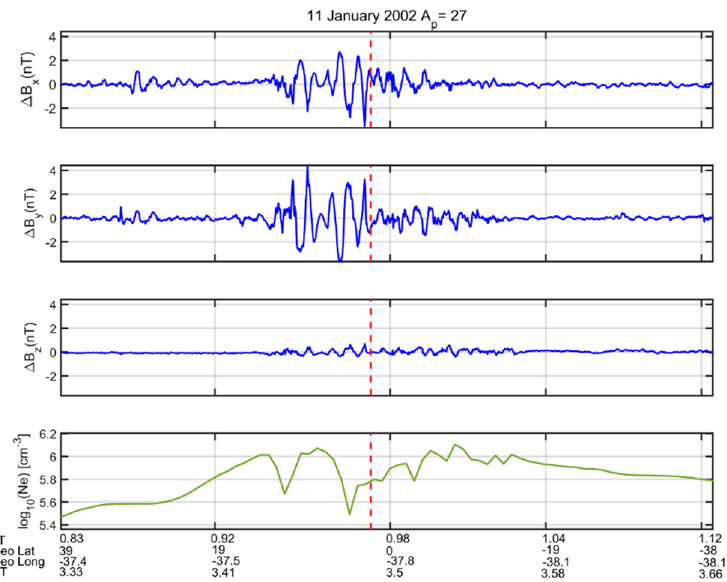
Figure 1. Top two panels show fluctuations in transverse components of the magnetic field measured by a vector fluxgate magnetometer on board the CHAMP satellite as it crossed the dip equator (indicated by the dashed vertical lines in each panel). The third panel shows fluctuations in the component parallel to the main geomagnetic field, which is taken to be in the z direction. Electron density measured by the PLP is plotted in the bottom panel, which shows the presence of EPBs.